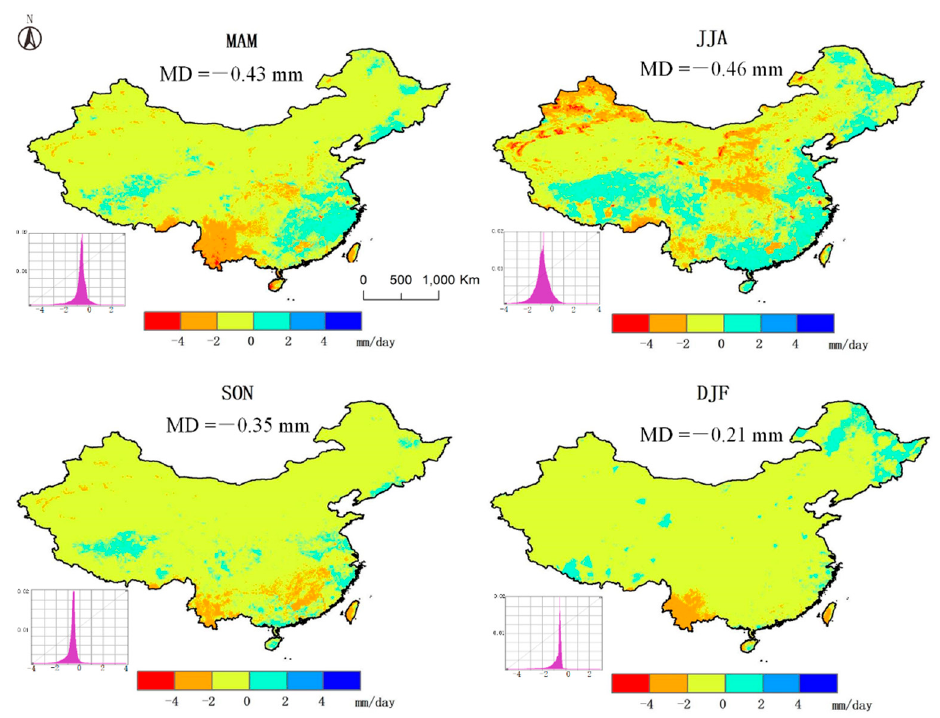
Figure 7. Comparisons of ET between the VIC simulation and the GLASS product of seasonal differences (VIC minus GLASS) for four seasons, from top to bottom, spring, summer, autumn, and winter. MD denotes the mean differences.